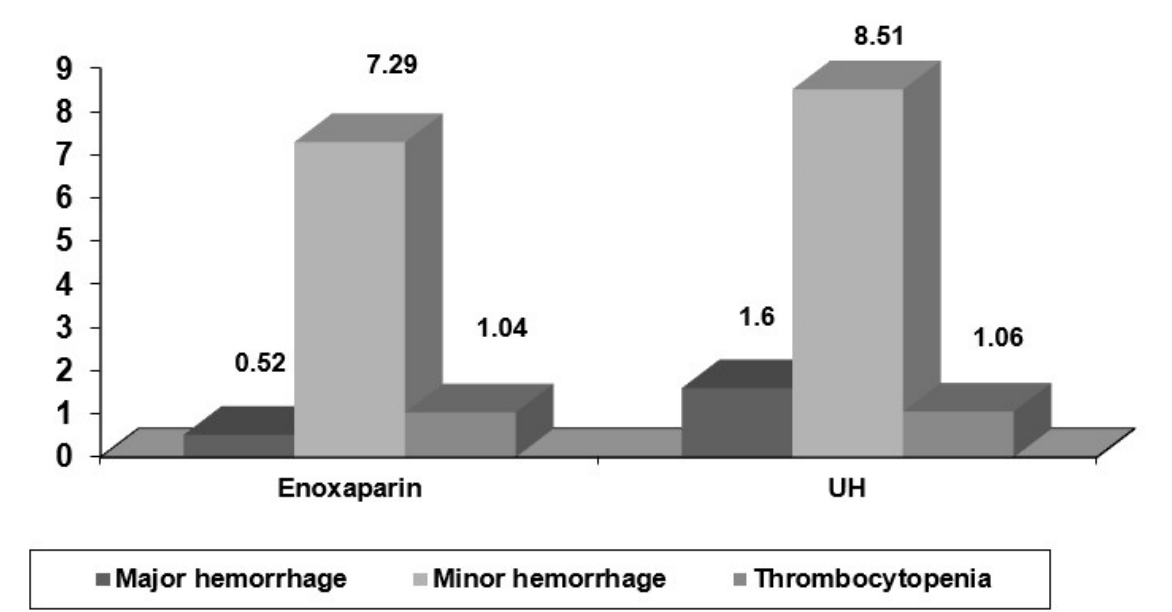
Figure 5. Incidence of bleeding complications and thrombocytopenia in the study